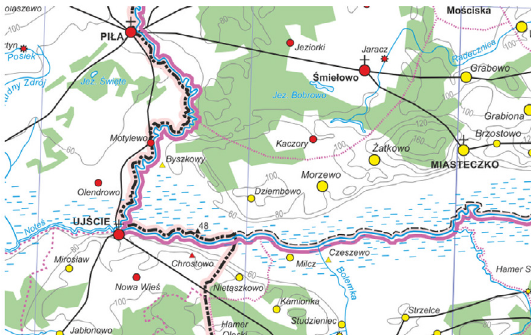
Fig. 1. Environs of towns Piła and Ujście on the main map at the scale of 1:250,000 in the volume Wielkopolska in the second half of the 16th century